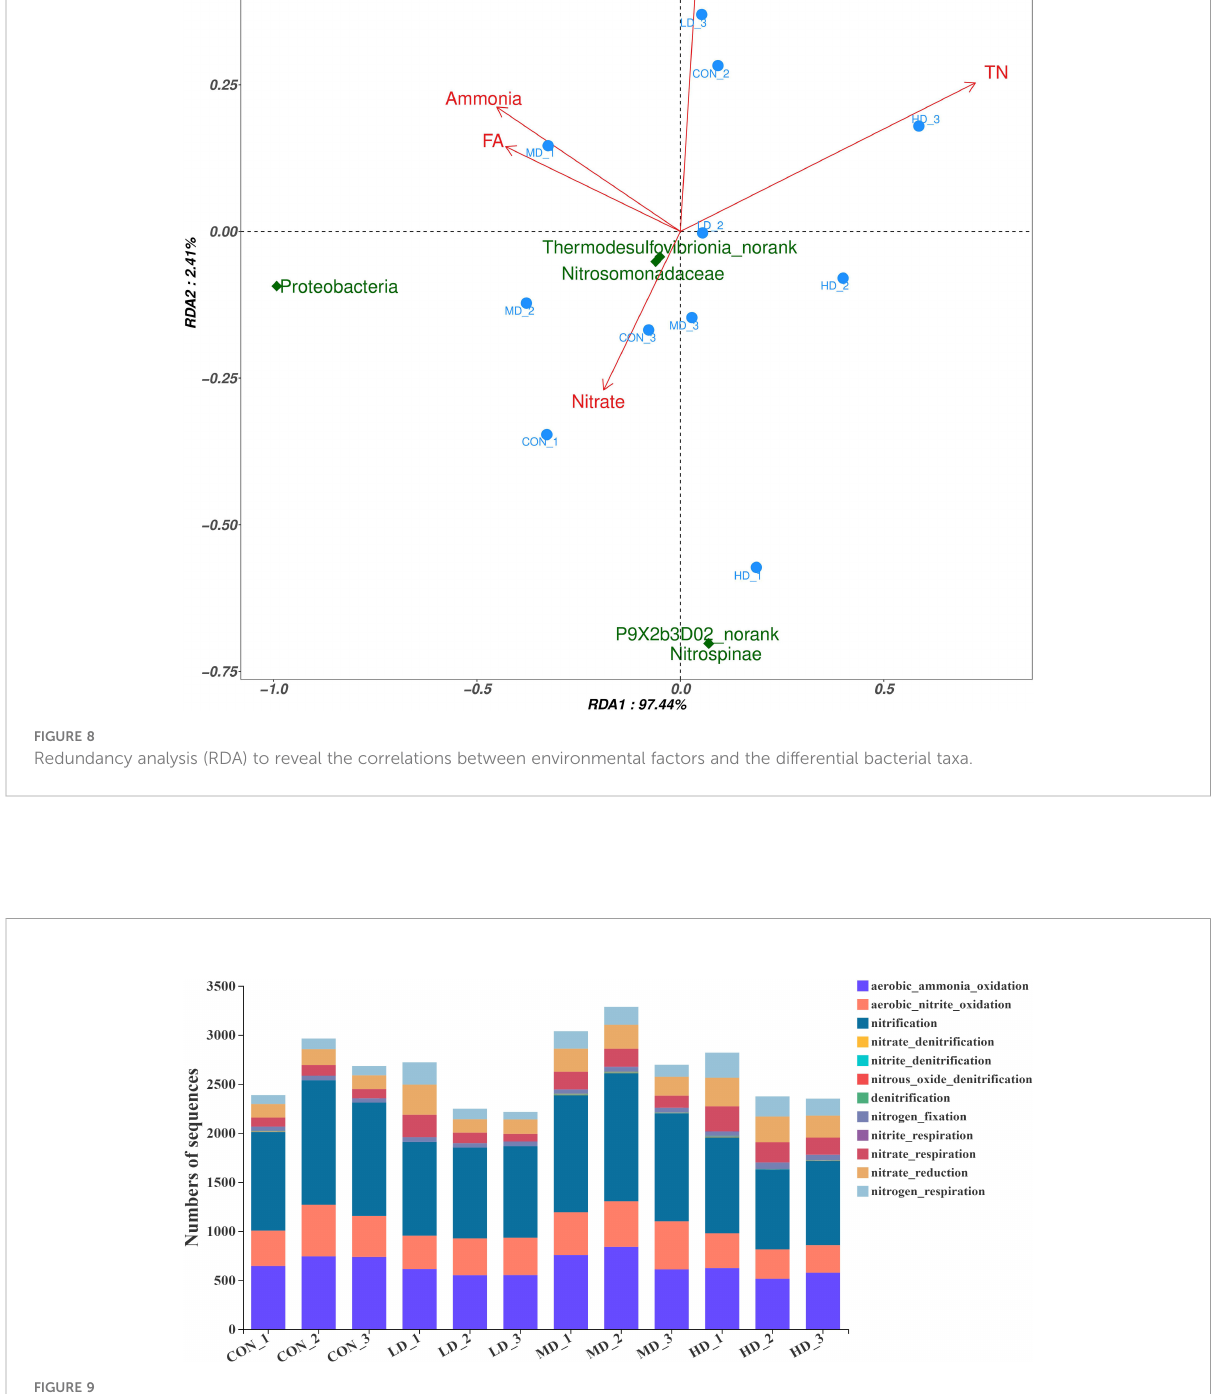
FIGURE 9 Functional groups related to nitrogen cycling in sediments of the CON, LD, MD and HD groups,